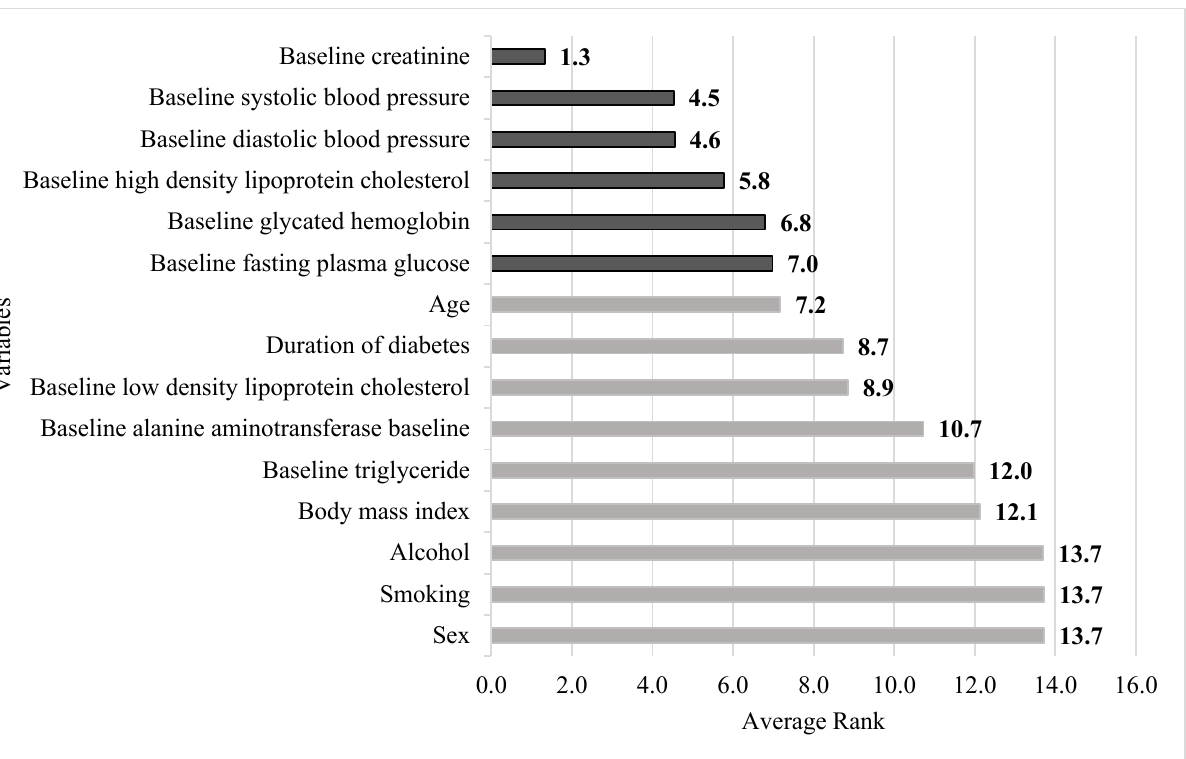
Figure 3. Integrated importance ranking of all risk factors. Note: The darker color indicates the first six important risk factors of this study.